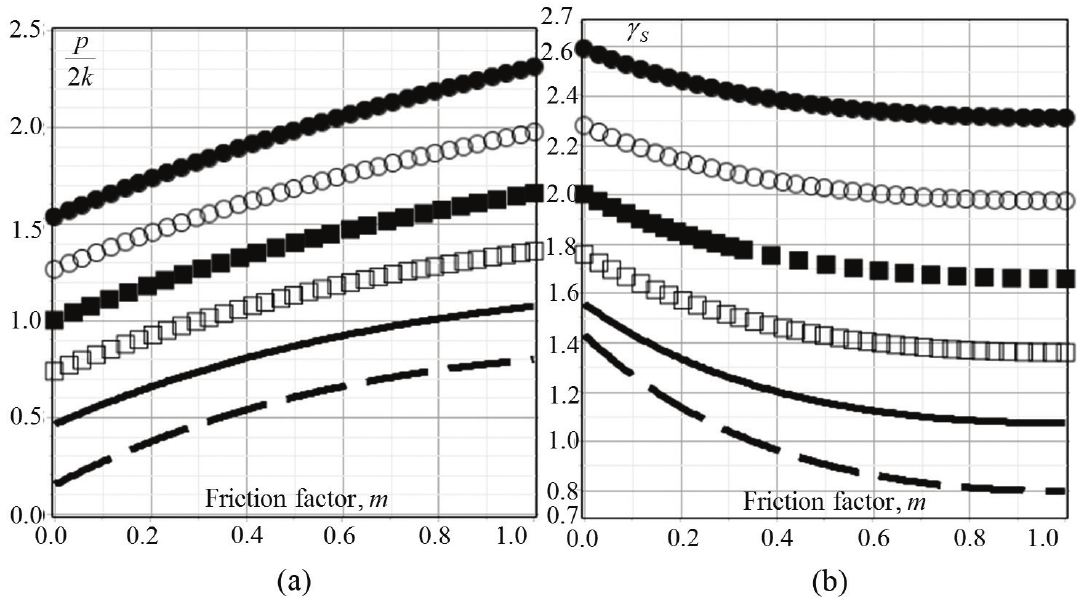
Figure 6. Dependences of relative punching pressure p/2k ( a ) and summary plastic shear γ with UBM for the following values of ECAE die channel intersection angles: ●●● ( 2 θ =60° ), 〇〇〇 ( 2 θ =75° ), ■ ■ ■ ■ ( 2 θ =90° ), □□□ ( 2 θ =105° ), ▬▬▬ ( 2 θ =120° ), and ▬▬ ▬▬ ( 2 θ =135°